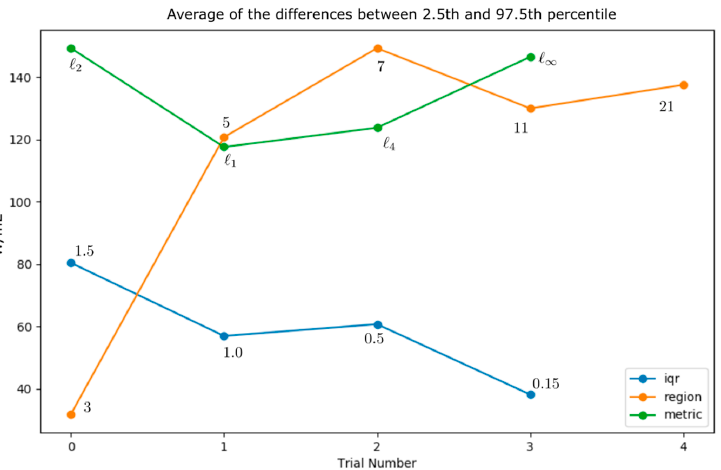
Figure 11. Trend of average of the difference between 97.5th and 2.5th percentiles for preserved scenarios for the summer: (blue) n R = 7 and metric = ℓ (cid:2870) -Norm and varying p : 1.5, 1, 0.5, and 0.15; (green) n R = 7, without outlier removal and varying metric : ℓ (cid:2870) -Norm, ℓ (cid:2869) -Norm, ℓ (cid:2872) -Norm, and ℓ (cid:2998) - Norm; (orange) metric = ℓ (cid:2870) -Norm, without outlier removal and varying n R : 3, 5, 7, 11, and 21. The text in the graph indicates the values assumed by the varied parameters.